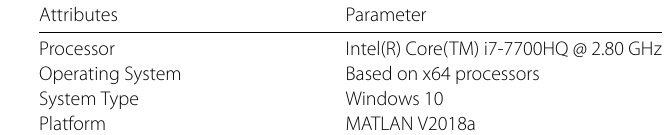
Table 1 Environment introduction